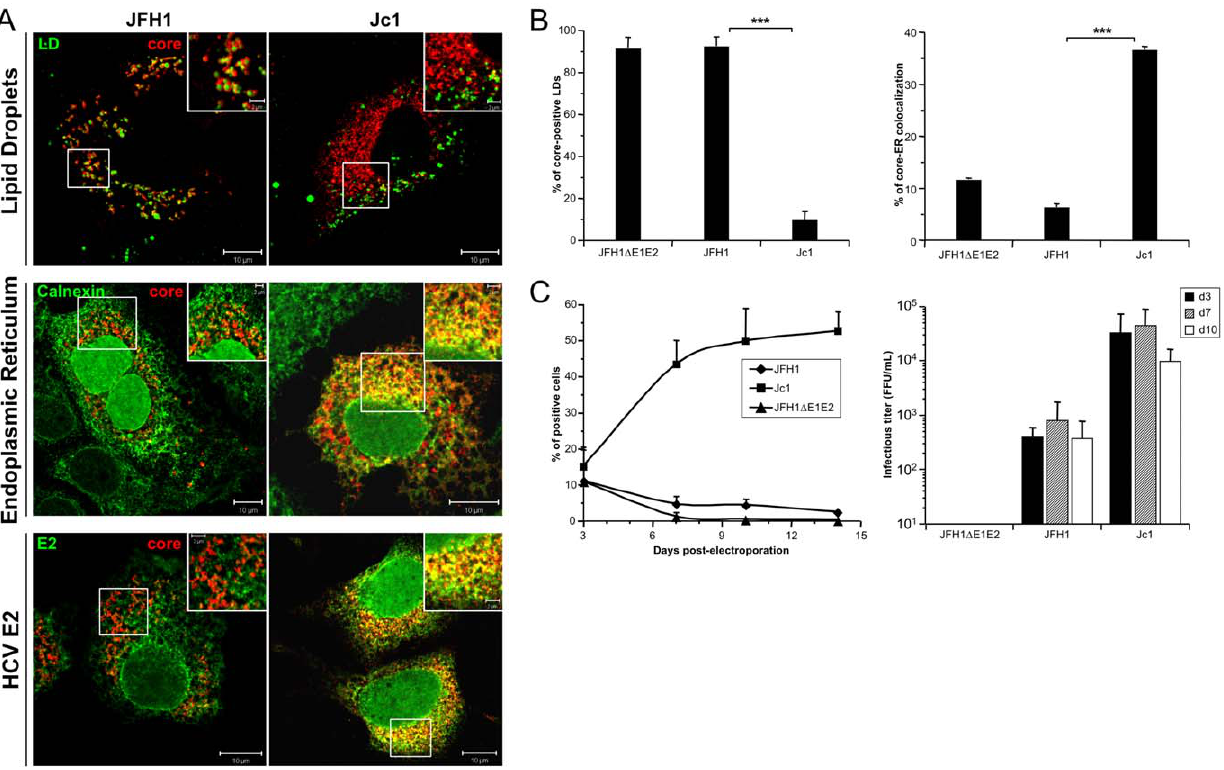
Figure 1. Differential intracellular localization of JFH1 and Jc1 core proteins expressed from HCVcc. Huh7.5 cells were transfected with RNAs from the full-length genomes of JFH1 and Jc1 HCV harboring a nucleus-targeted Venus YFP reporter gene, fixed 72 h post-transfection and stained for LDs, Calnexin, HCV core and E2 proteins. Colocalization of core proteins (red channel) with LD, ER and E2 (green channels) was analyzed by confocal microscopy. Typical patterns of intracellular localization of either protein are shown. The scale bars are provided in each panel as well as in zooms from squared areas. The green fluorescence detected in the nuclei of cells stained with Calnexin and E2 antibodies are those of the nucleus- targeted Venus YFP expressed by the HCVcc. The same differential core-LD vs. core-ER localization between JFH1 and Jc1 were detected whether these HCVcc harbored or not this YFP reporter gene (Figure S1B) ( A ). The frequency of JFH1 or Jc1 core-positive LDs (mean % 6 SD) was determined in HCVcc-containing cells stained for core and LDs (left panel). The percentages of core-ER colocalization (mean % 6 SD) were determined by expressing the coefficients of determination based on Pearson’s correlation coefficients of colocalization of core and Calnexin (right panel). For each condition, 30–50 cells were quantified. (*), P , 0.05; (**), P , 0.01; (***), P , 0.001; (ns), no significant difference ( B ). The viral spread in cells expressing JFH1 and Jc1 HCVcc and the JFH1 D E1E2 negative control was followed by detection of the YFP reporter gene for 14 days (left panel) and the infectious titers (mean 6 SD, n=4) were determined at 3, 7 and 10 days post-transfection (right panel) ( C